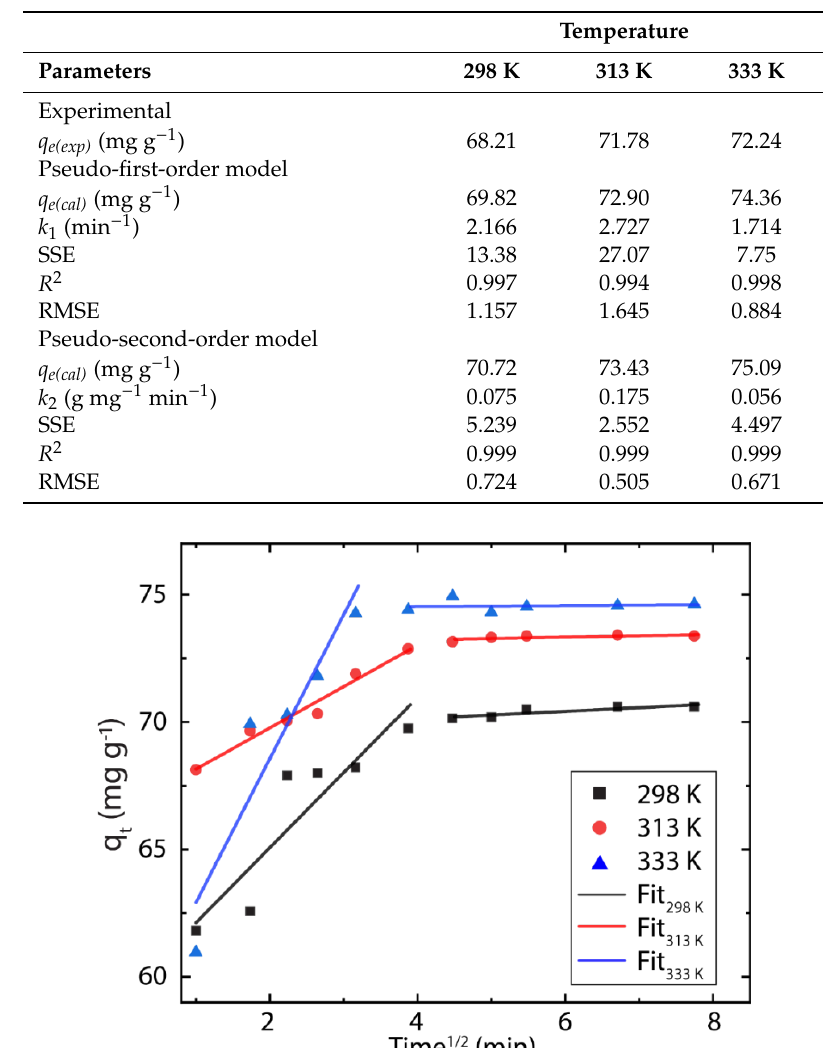
Table 2. Parameters of the intraparticle diffusion (IPD) model for the MB adsorption on rGO, considering different temperatures.